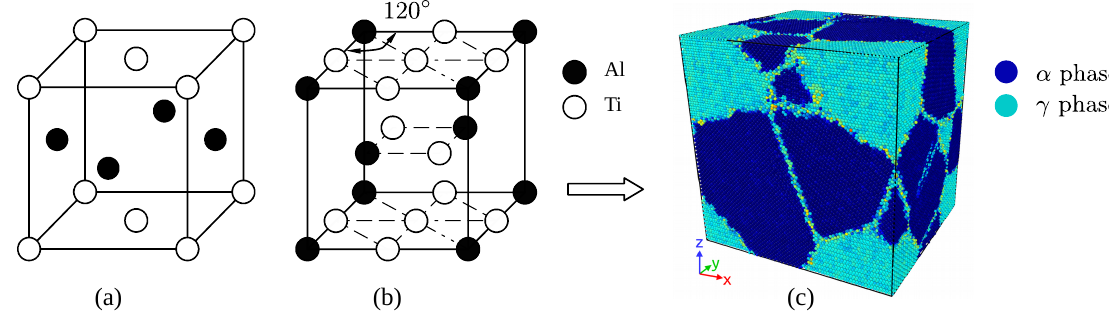
Figure 1. Unit cell of TiAl ( a ), Ti 3 Al ( b ) and two-phase Ti–Al model ( c